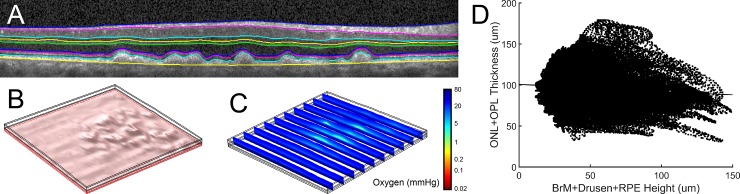
Patient-specific retinal mapping and finite element modeling.(A) Semi-automated segmentation of the retina was performed by evaluating sequential OCT B-scans. (B) Three-dimensional drusen morphology shown in a patient’s retina using co-registration of B-scans with fundus photography. (C) Ten evenly-spaced cross-sections showing the partial pressure of oxygen throughout a patient’s retina including regions of mild hypoxia near the fovea.